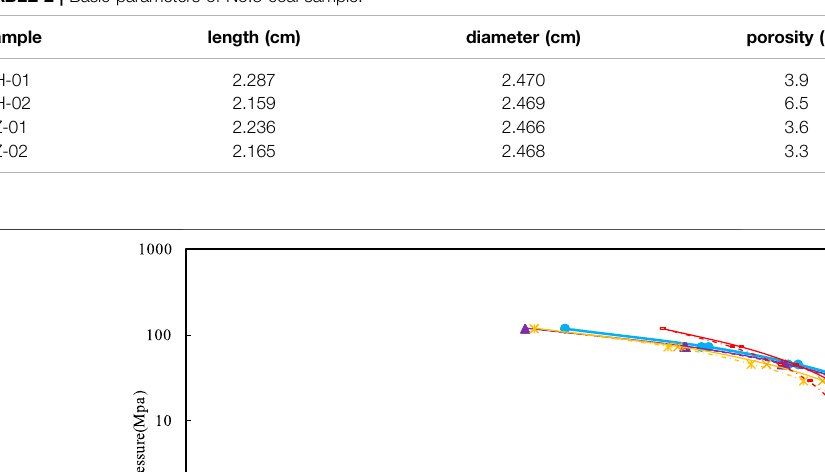
TABLE 2 | Basic parameters of No.3 coal sample.